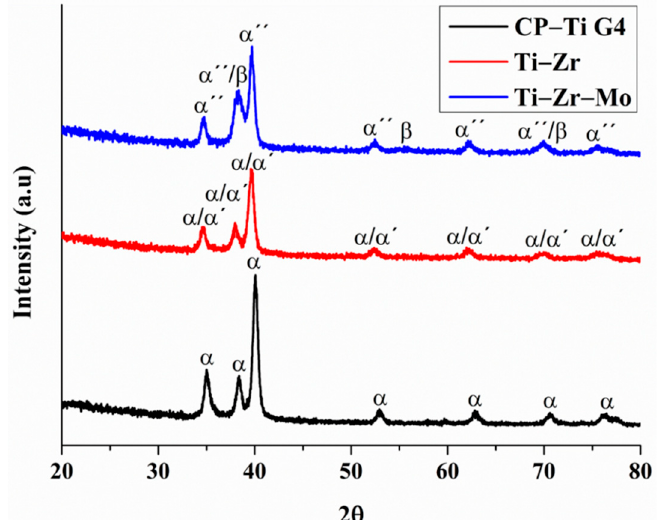
Figure 2. X ‐ ray diffraction patterns of the samples with α (alpha phase), α ’ (martensitic alpha Figure 2. X-ray diffraction patterns of the samples with α (alpha phase), α (cid:48) (martensitic alpha phase), phase), α ’’ (metastable alpha phase) and β (beta phase) identified. α ” (metastable alpha phase) and β (beta phase)